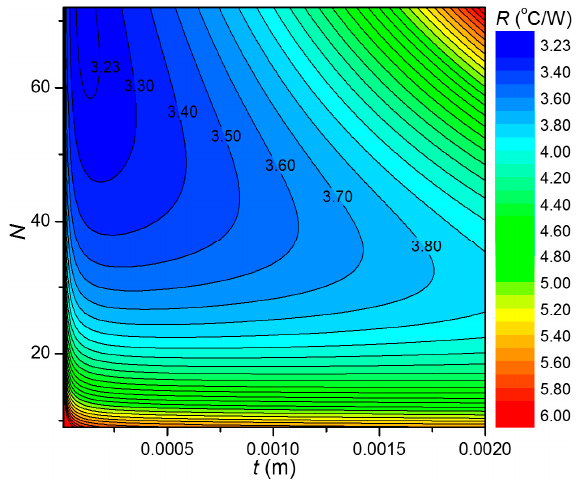
Figure 12. Contour map of thermal resistance.